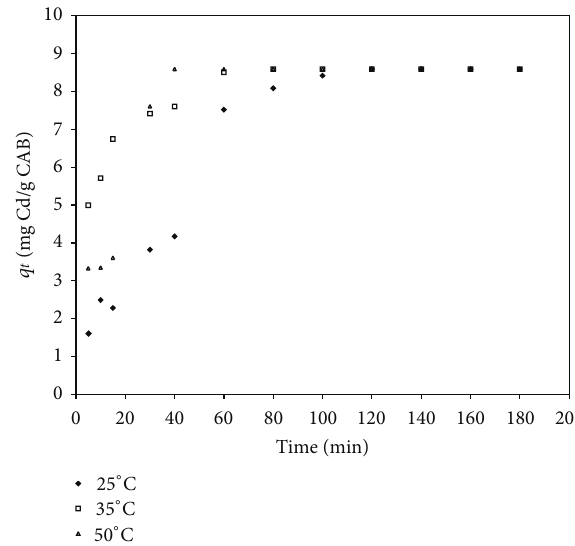
Figure 1: Adsorption capacity ( 𝑞 𝑡 ) of cadmium by CAB at different temperatures ( ∘ C) versus time (min).